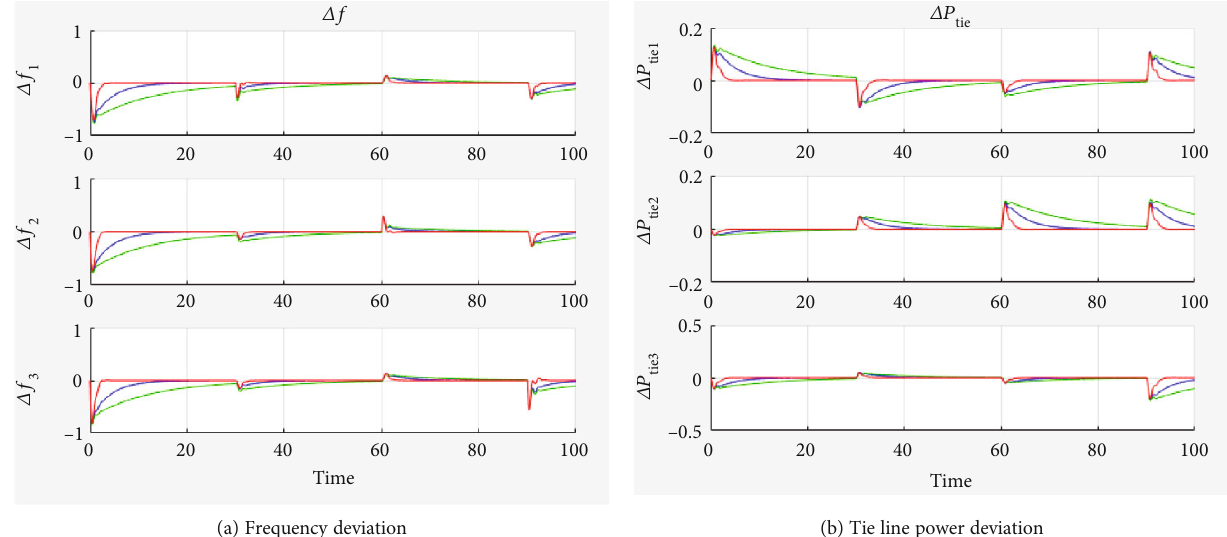
Figure 14: Response of the system under sudden load change from 0.2 to 0.4 p.u in area 1 at 30 seconds, load change from 0.4 to 0.2 p.u in area 2 at 60 seconds, and load change from 0.5 to 0.9 p.u in area 3 at 90